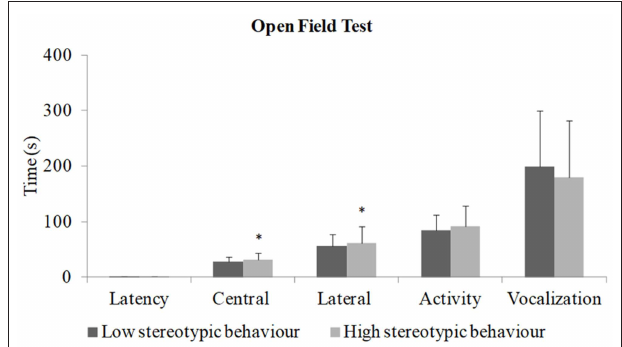
FIGURE 2 | Open field test in the piglets ( N total = 142, N = 76 piglets from sows with a low rate of stereotypy and N = 66 piglets from sows with a high rate of stereotypy). *Indicates difference in central sectors ( t -test; p = 0.000) and lateral sectors ( t -test; p = 0.04). There was no difference in the latency (Mann–Whitney U -test; p = 1.00), activity ( t -test; p = 0.54), and vocalization ( t -test; p = 0.34).